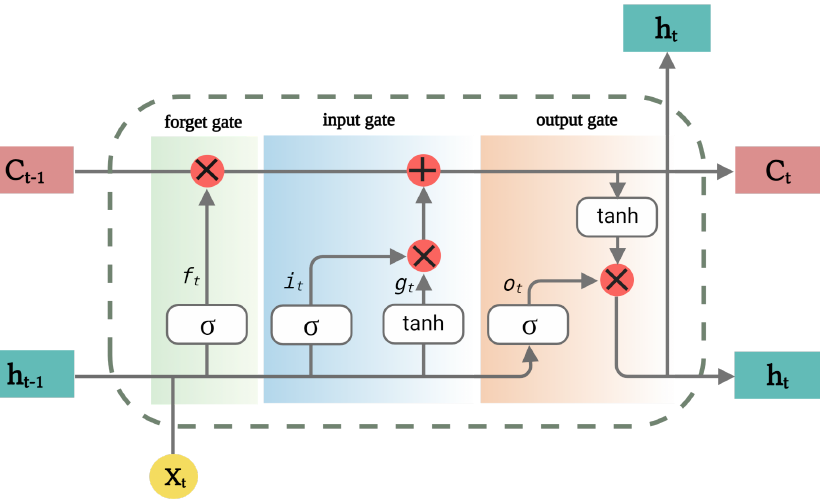
Figure 3. The LSTM memory